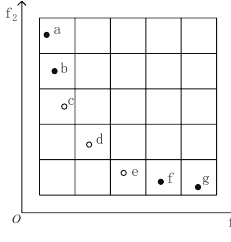
Fig. 5. Archive members updated by improved ε -